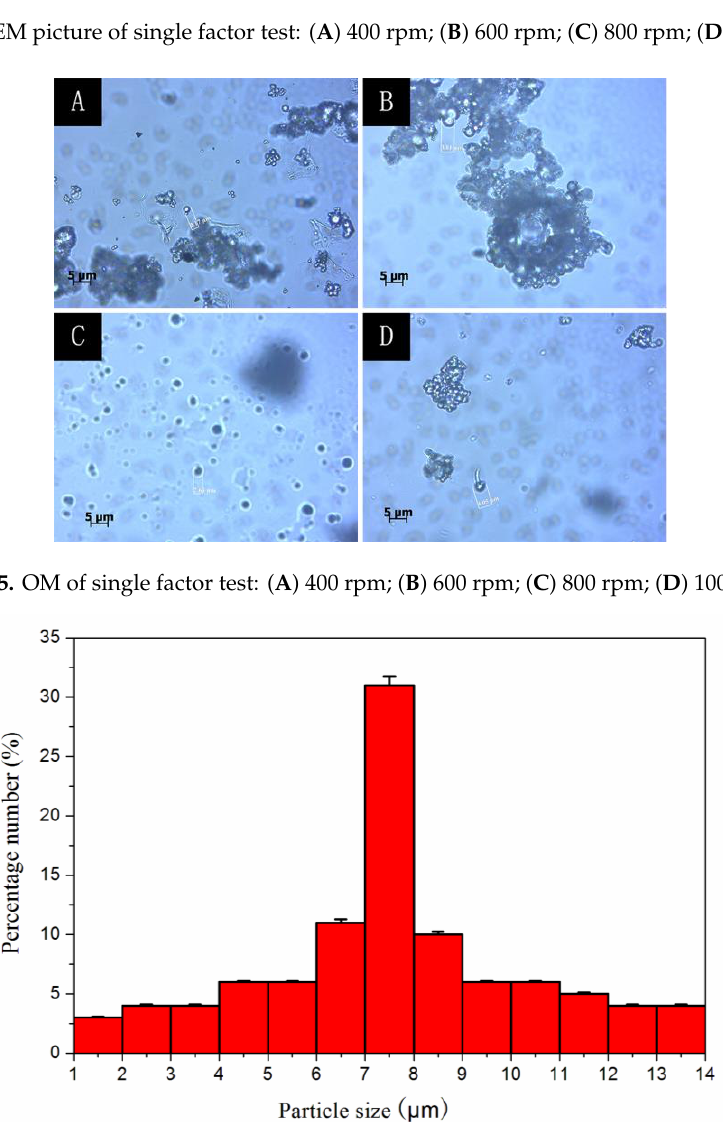
Figure 6. The particle size distribution of microcapsules (Sample 18 in Table 3).